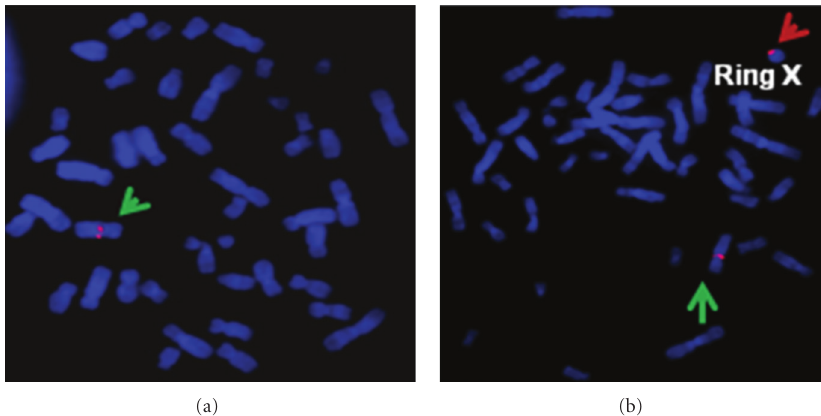
Figure 3: FISH of metaphase spread with the Vysis LSI AR DNA probe, which hybridizes the X chromosome q11-12. Green arrows indicate normal X chromosome, whereas red indicates ring form of the X chromosome. (a) 45,XO karyotype showing androgen receptor signal. (b) Androgen receptor signals in metaphase with 46,X+ringX karyotype.